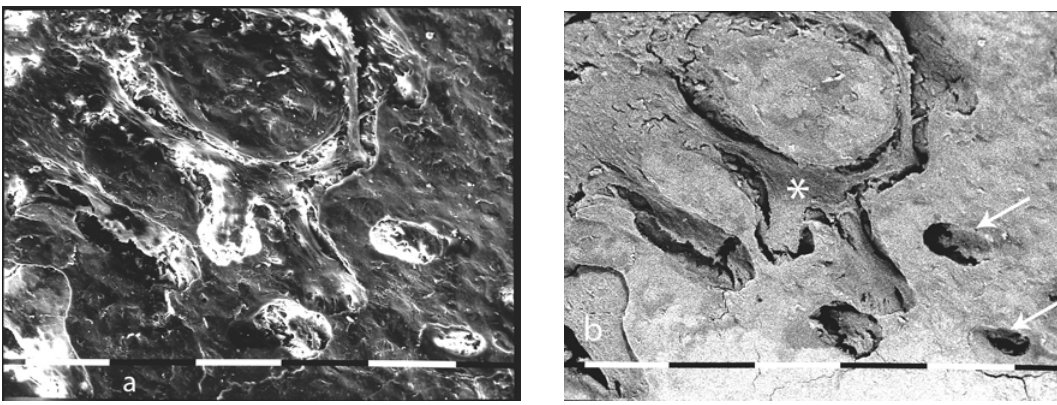
FIGURE 13 . SE (a) and BSE (b) images of peri-implant tissue around Zr-SLA implant 3 months after surgery. Some areas of mature lamellar bone in direct contact with the implant surface and thin residual marrow spaces (*) with cell lacunae (arrows) are detectable. Bar = 10 µm.